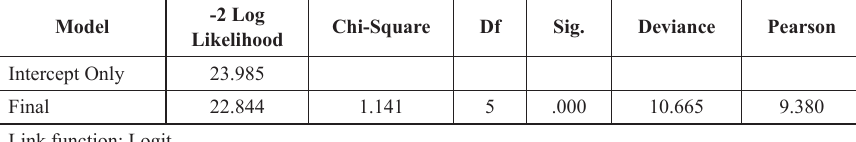
Table 6. The model fitting information for academic teacher’s answers